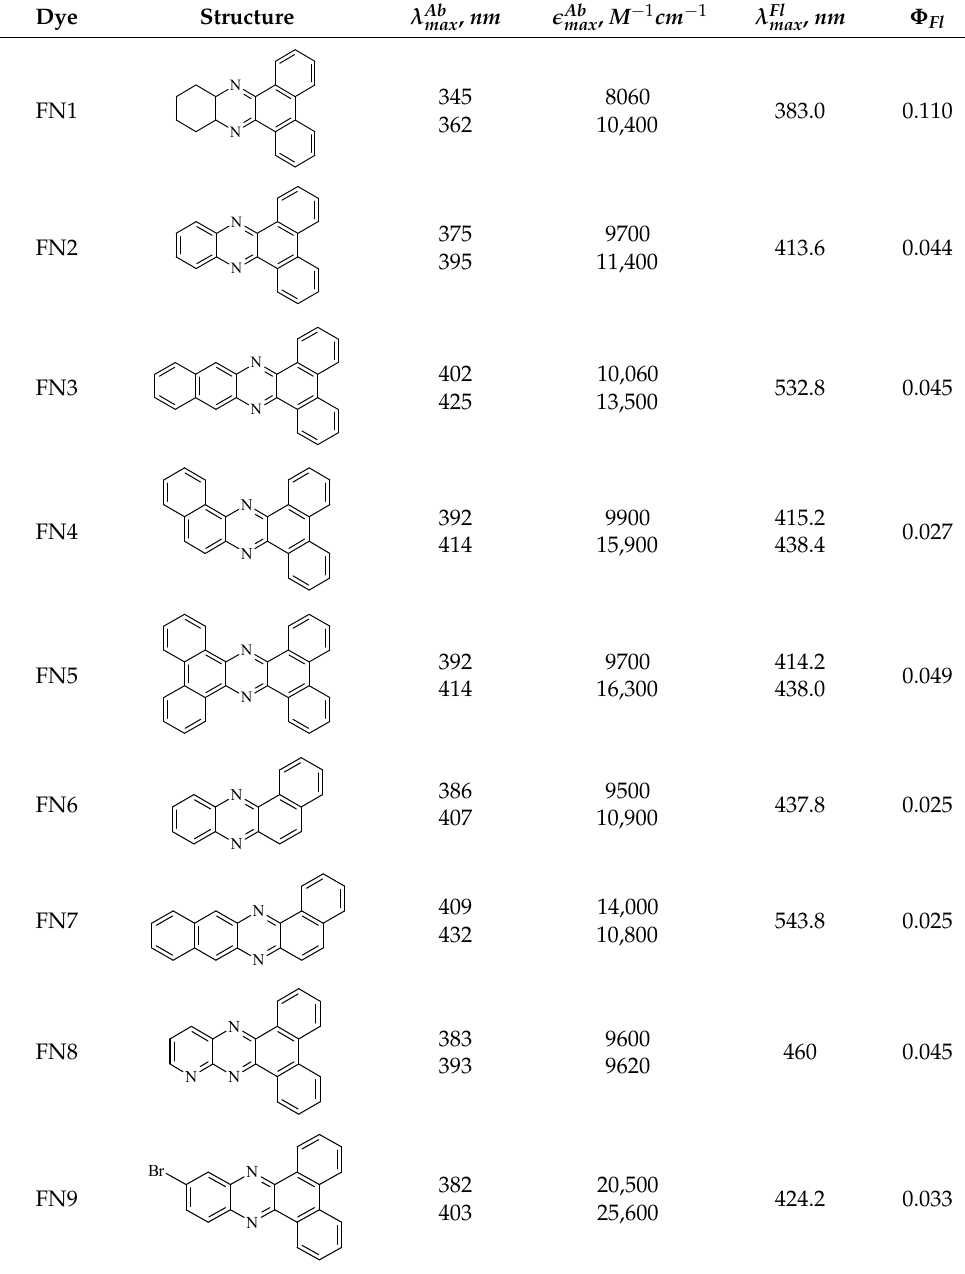
Table 1. Structures, basic spectroscopic properties, and quantum yields of fluorescence for the dyes tested. Dye Structure